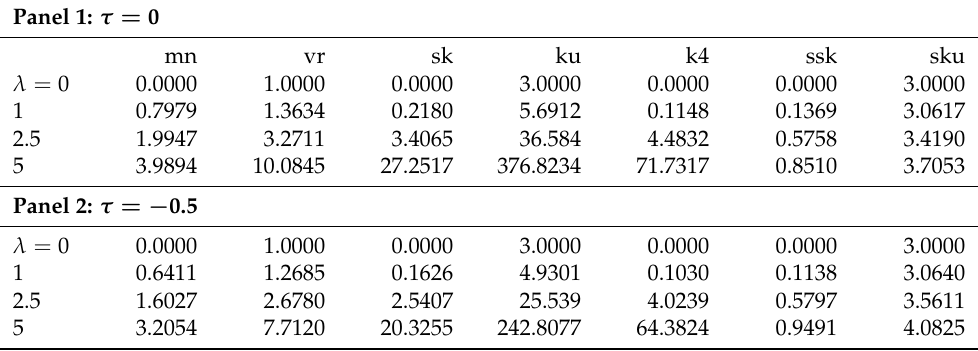
Table 3. Moments of the extended skew-normal distributions, τ ≤